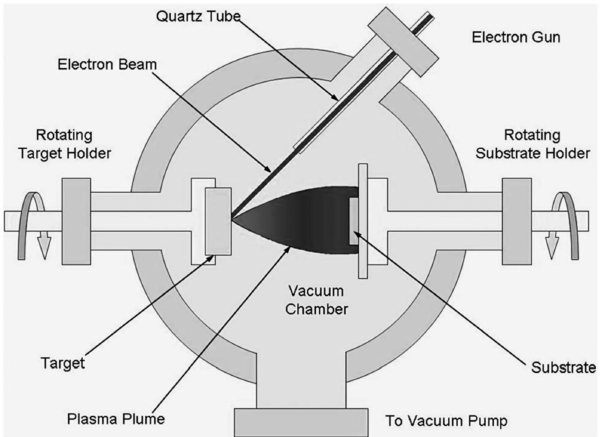
Figure 1. Scheme of the pulsed plasma deposition process, reproduced from [15] with permission from the Royal Society of